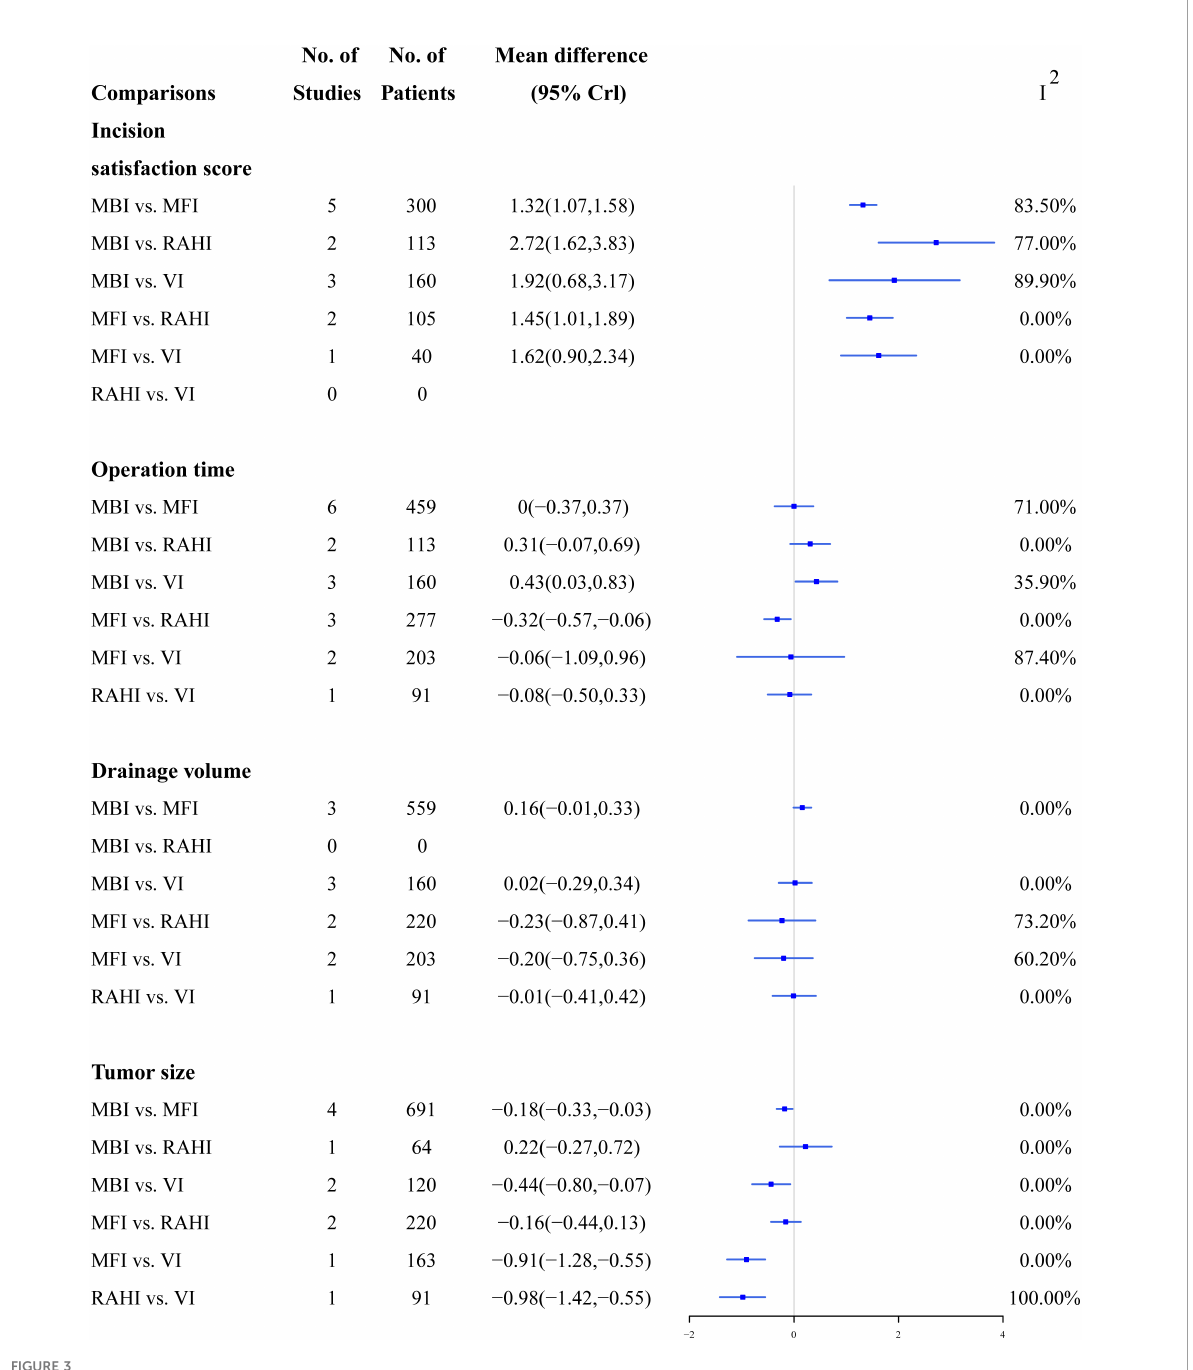
FIGURE 3 A direct comparison forest map of continuous